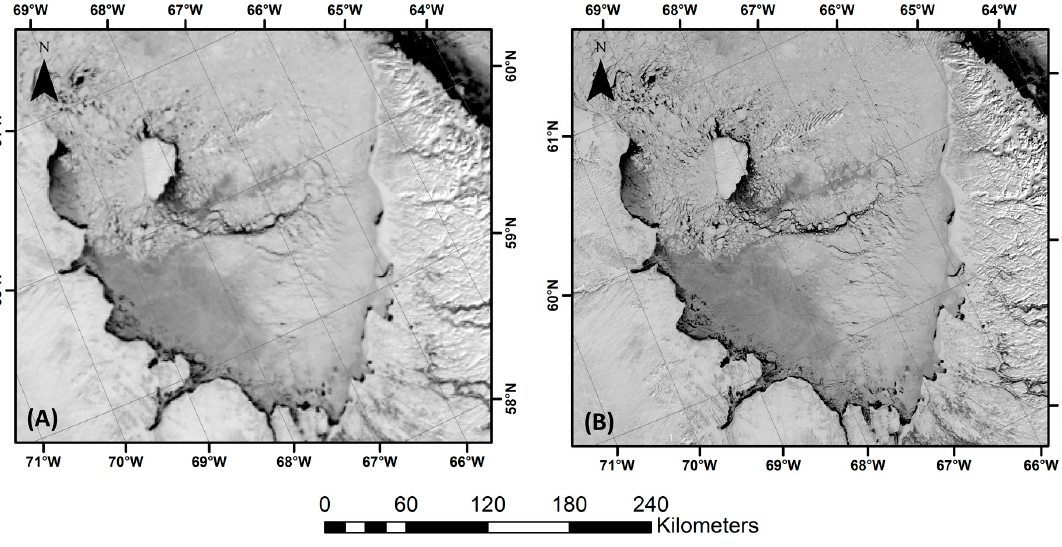
Figure 5. ( A , B ) Downscaling example over Ungava Bay in the Hudson Strait area on 15 March 2014. The original 500 m Band 4 (green band) data is on the left and the downscaled result at 250 m is on the right.